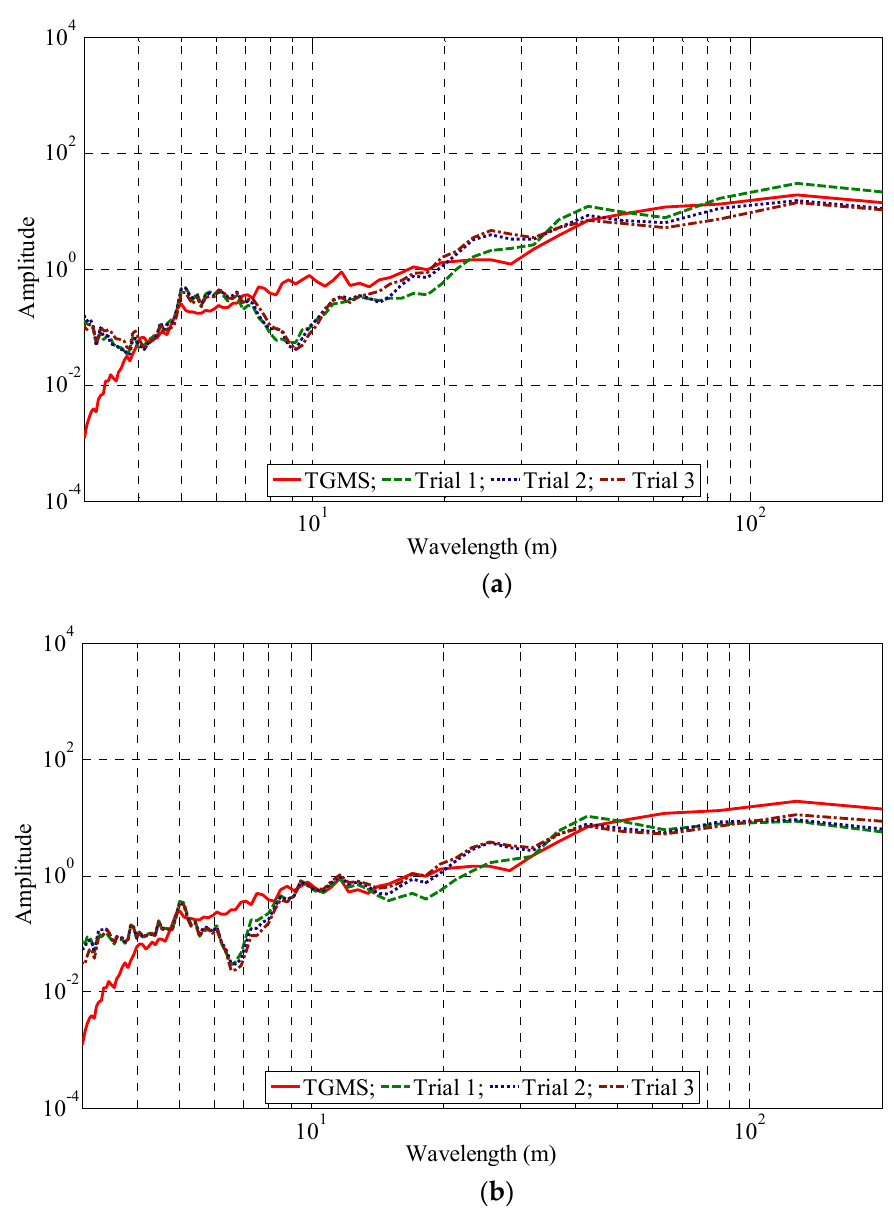
Figure 12. Estimation of lateral track irregularities in the wavelength domain: ( a ) axle box-mounted accelerometer; ( b ) bogie-mounted accelerometer.